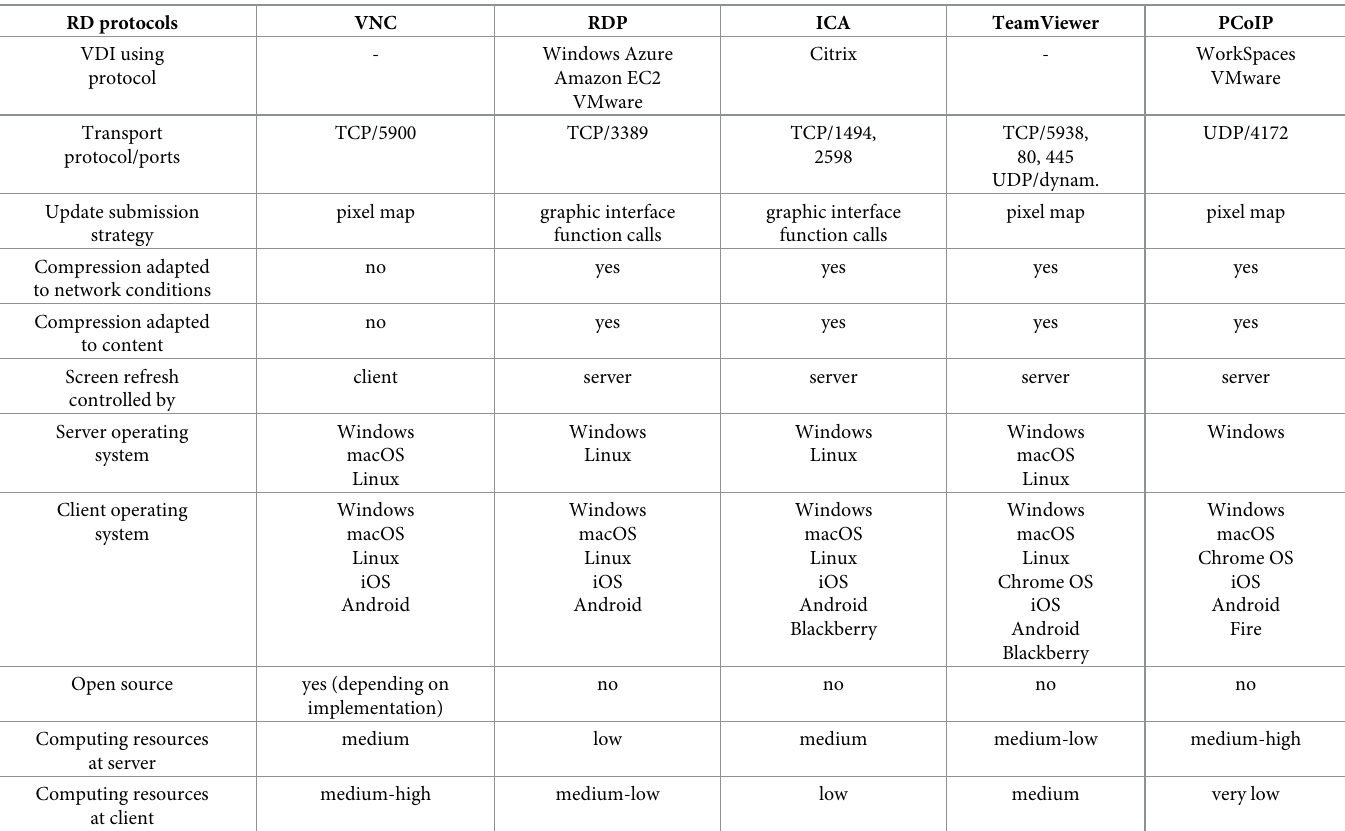
Table 1. Characteristics of RD